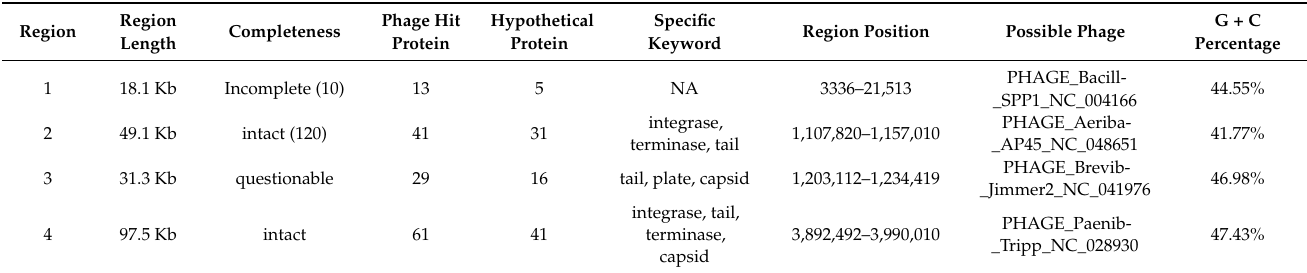
Table 4. Prophage regions found in Bacillus velezensis KS04AU genome.